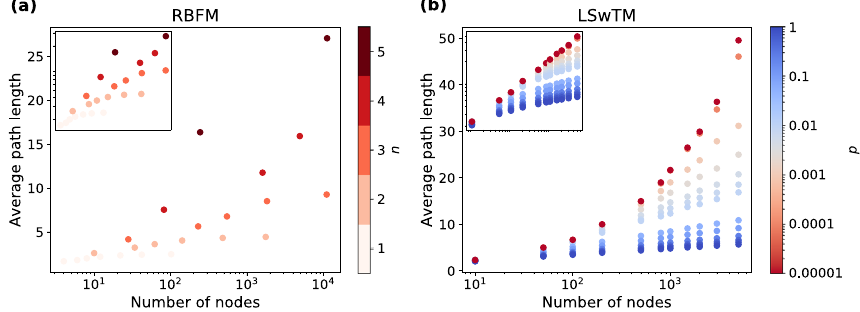
Fig. 25 Average path length as a function of the logarithm of the size for some cases of the a Repulsion‑based fractal model, b Lattice small‑world transition model. On subplot a the networks are generated by setting parameter Y to 0, and the coloring is based on parameter n . On subplot b the coloring is based on parameter p . The insets are showing the log–log plots of the same